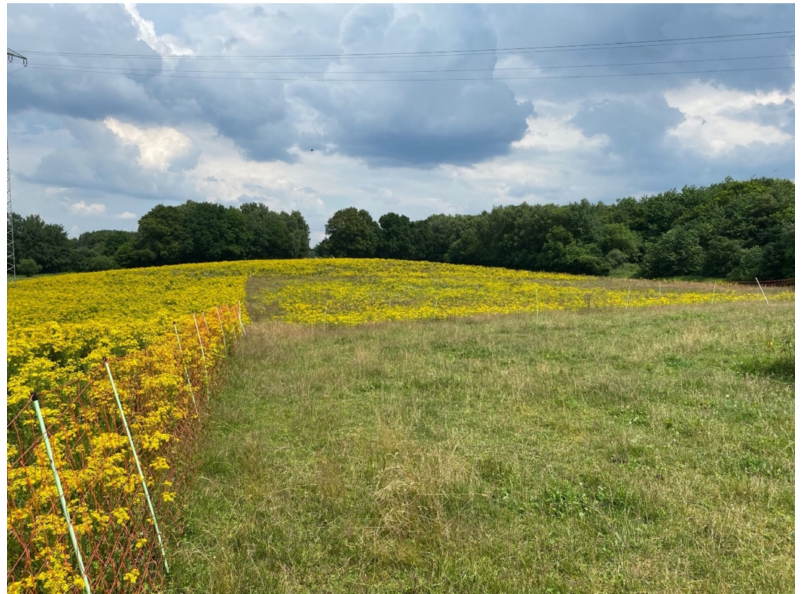
Figure 9. Left of the fence: pasture grazed by cattle only; in the background: pasture grazed by sheep six weeks earlier (ragwort grew back and flowered, but was only about half its usual height, less dense, and clearly reduced); in the foreground: area currently grazed by sheep. (Date: 12 July